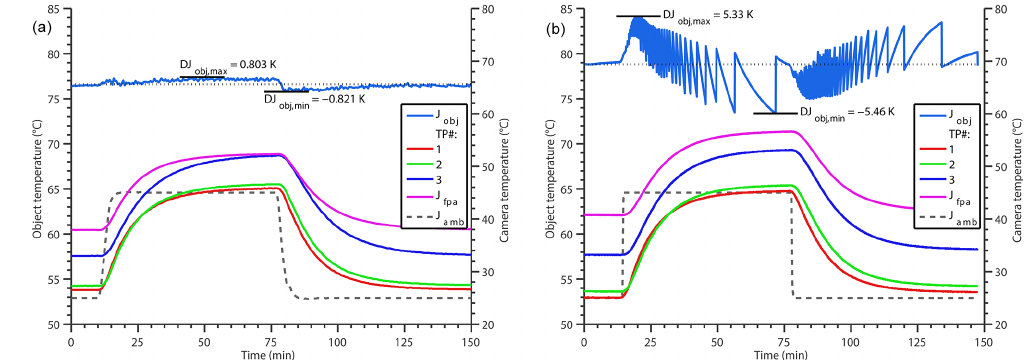
Figure 9. Comparison of the correction of (a) the shutter-less and (b) shutter-based IR cameras for ambient temperature jumps from 25 to 45 ◦ C and back. The non-continuous shape of the shutter-based correction is due to the shutter procedure and the thermal drift occurring afterwards. The residual measurement uncertainty of the shutter-less approach is significantly lower due to the continuous online